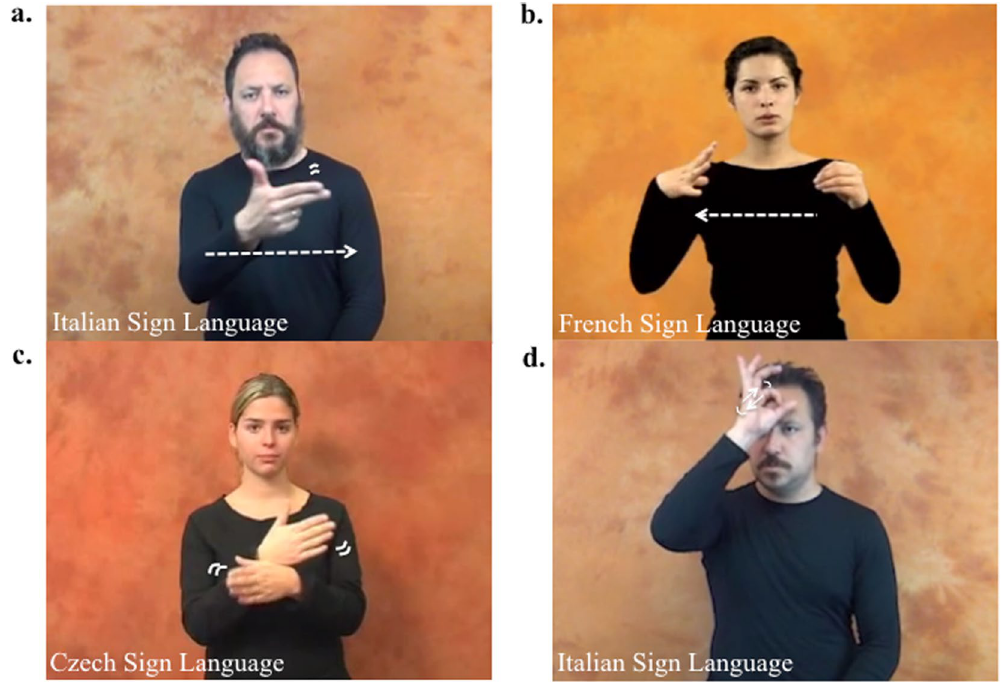
Figure 1. Examples of the signs fish (Panel a,c) and zucchini (Panel b,d) in different sign languages. Fish is represented in a specific orientation in the Italian Sign Language (Panel a) but not in the Czech Sign Language (Panel c), while zucchini is represented in a specific orientation in the French Sign Language (Panel b) but not in the Italian Sign Language (Panel d). The pictures of the signs were taken from